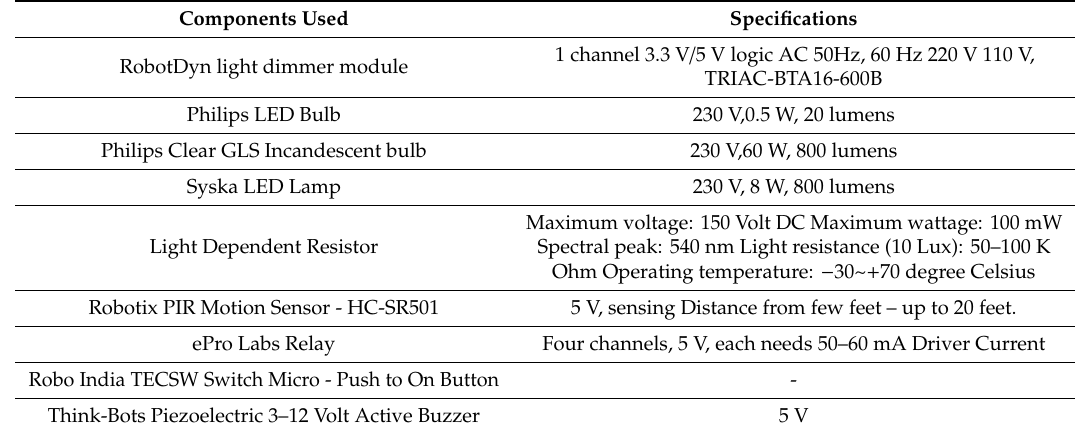
Table 2. PARSLAD